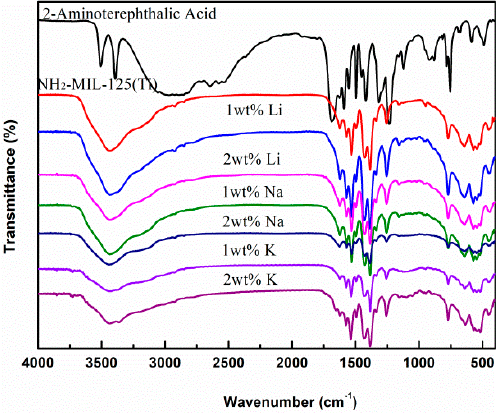
Figure 1. FT-IR spectra of H 2 BDC–NH 2 , NH 2 –MIL125(Ti) and x M@NH 2 –MIL125(Ti).